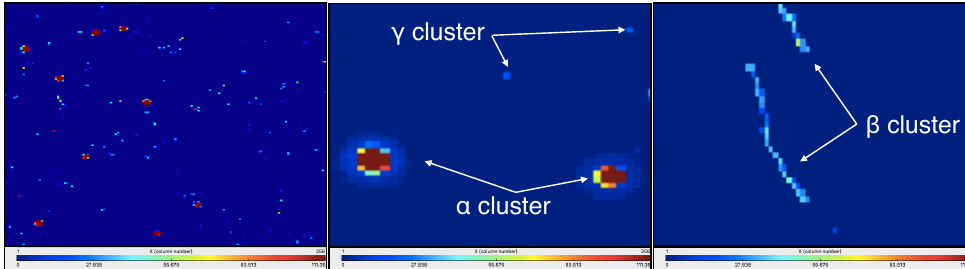
Figure 2. Left canvas: typical TimePix frame acquired for radon measurement in the ‘bare’ configura- tion (no holder). Other two canvas: clusters shape for α , β and γ particles interacting with Timepix detector. The clusters appear circular for α particles, dots for photons, and long tracks for electrons. The deposited energy is represented by the colored scale below the